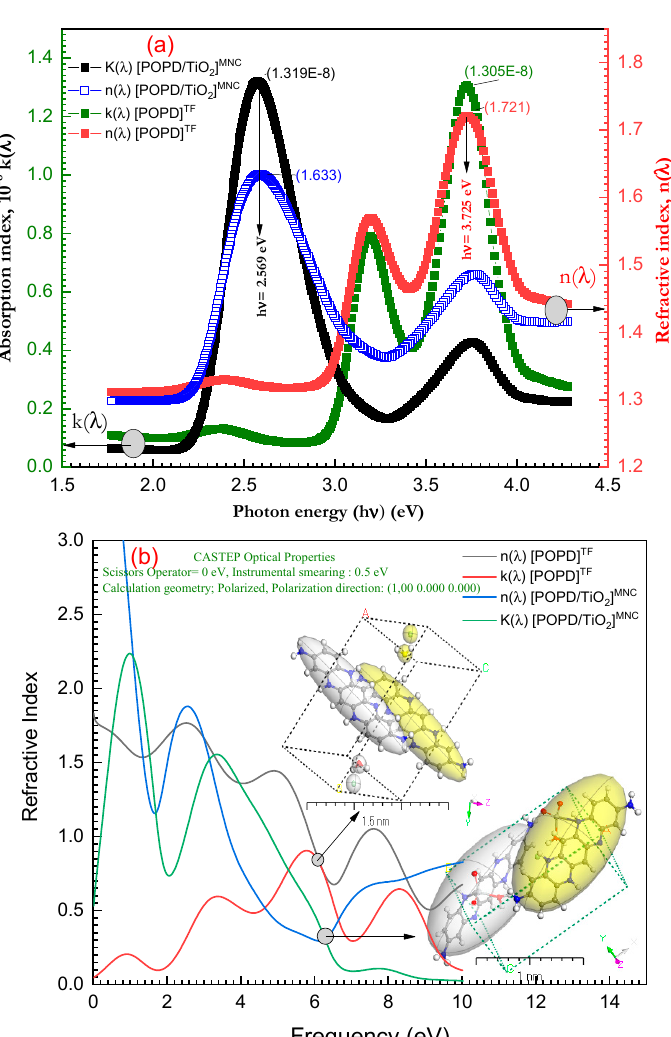
Figure 9. ( a ) n( λ ) and k( λ ) spectral dependency per λ , ( b ) simulation via CASTEP optical properties for [PoPDA] TF and [PoPDA/TiO 2 ] MNC.